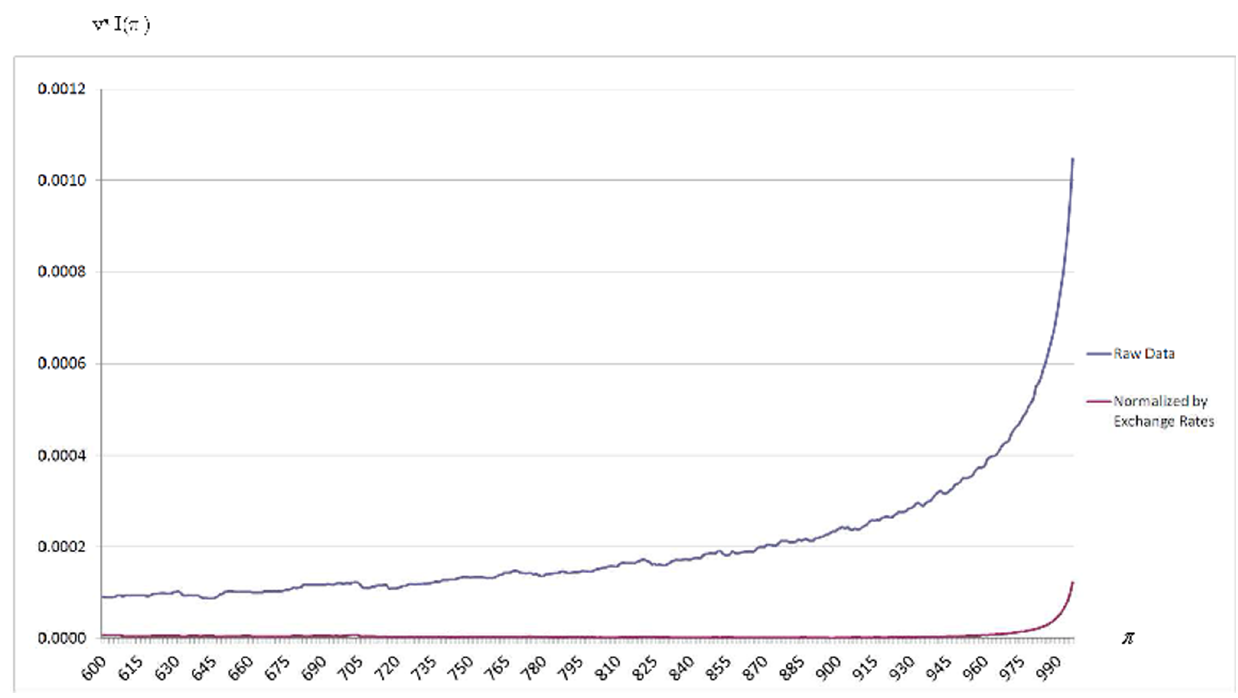
Figure 2. Weighted Citation Inequality Due to Differences in Citation Practices, v p I ( p ) , as a function of p . Raw vs. Normalized data. Results for the ½ 600,996 (cid:2) quantile interval.